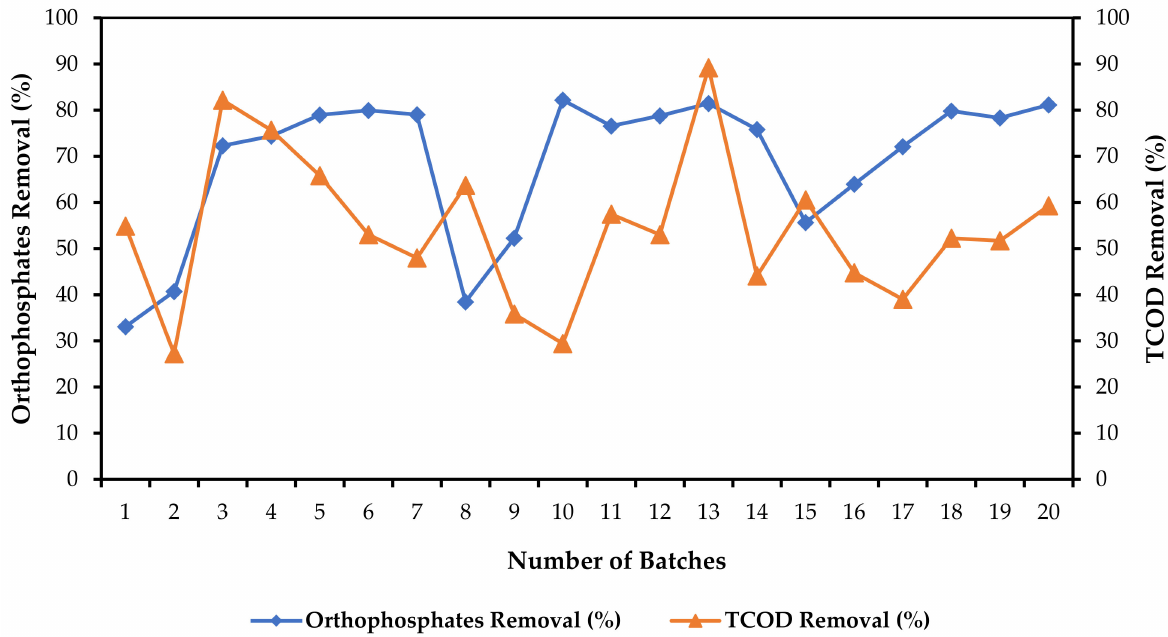
Figure 7. Orthophosphate and TCOD removal profile.